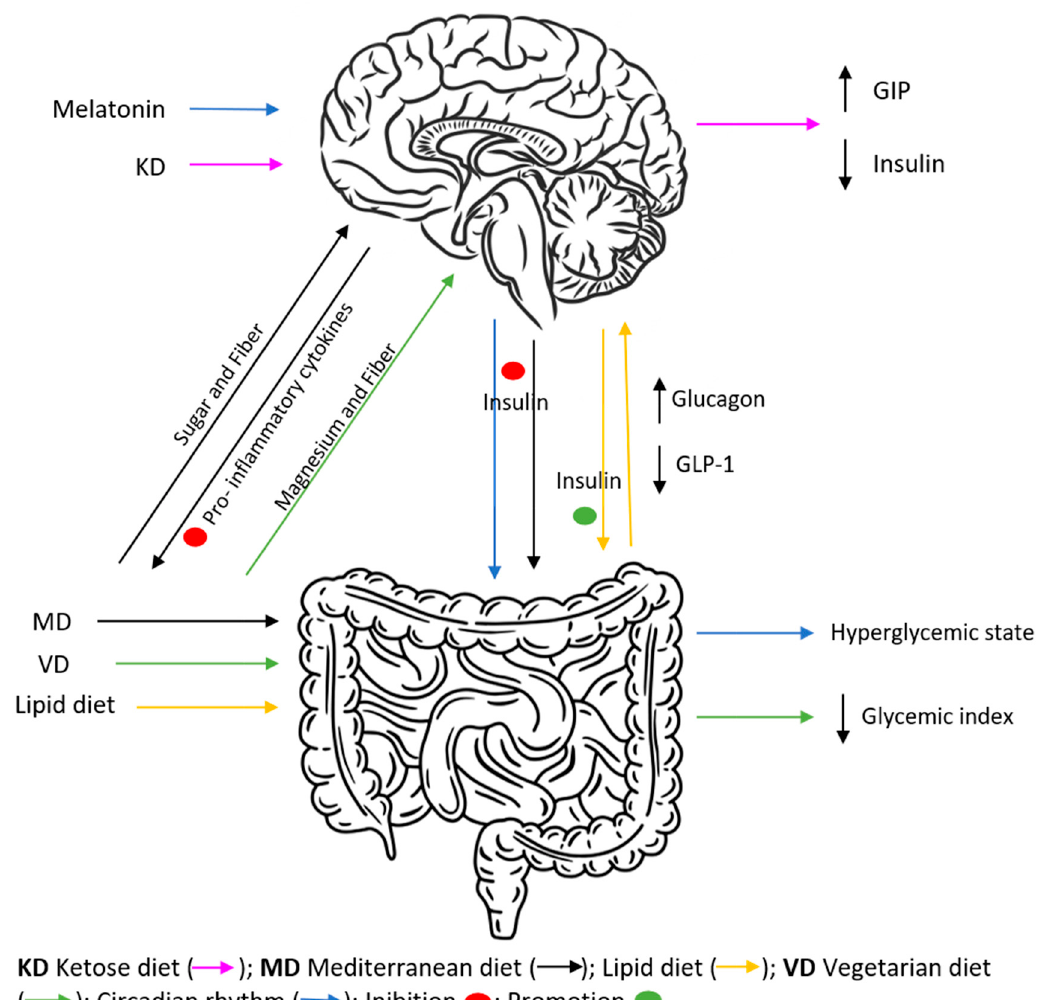
Figure 1. Effects of different diets on insulin and incretins secretion, as well as hyperglycaemic and inflammatory states. KD, characterized by the ingestion of <50 g of carbohydrates/day, promotes a decrease in insulin and increase in glucagon and GIP fasting levels. MD, because of its higher fiber supply and reduced sugar ingestion, is capable of decreasing blood insulin levels and increasing GIP secretion, similarly decreasing pro-inflammatory cytokine activation and reducing the risk of diabetes development. VD, based on reduced calorie ingestion and being rich in magnesium and fibre, promotes a decrease in GI. A lipid diet is associated with diabetes development by increasing glucagon secretion and decreasing